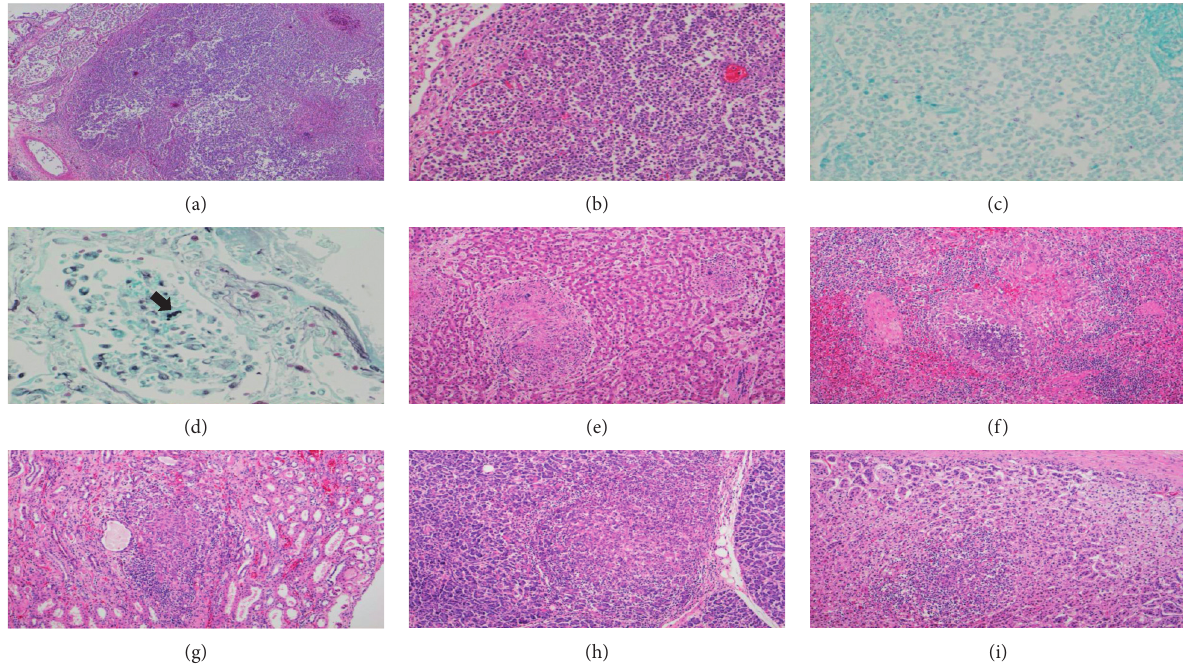
Figure 4: Excessive neutrophil accumulation with necrosis in the lung ((a) × 40; (b) × 100). Numerous acid-fast bacilli with Ziehl–Neelsen stain ((c) × 400) and round to oval cysts with Grocott’s methenamine silver nitrate stain ((d) × 400). Granulomas present in the liver (e), spleen (f), kidney (g), pancreas (h), and adrenal gland